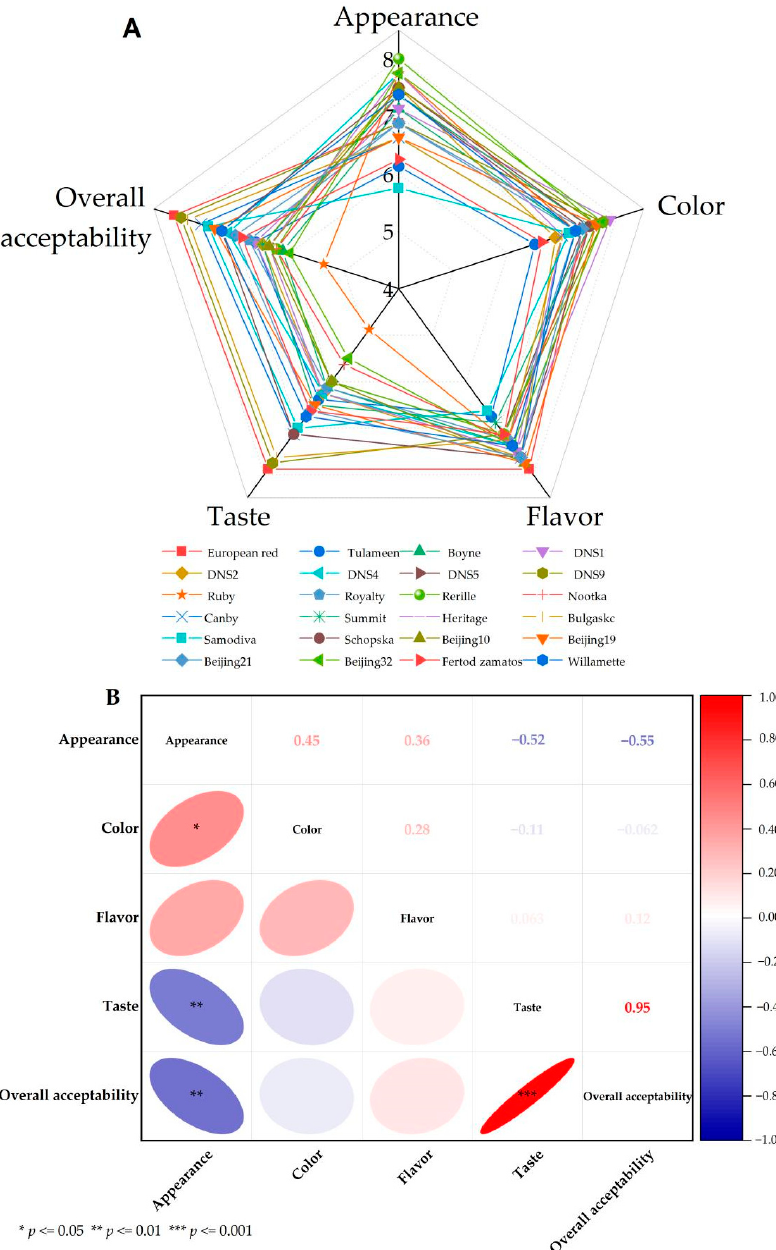
Figure 2. Radar plot showing sensory characteristics evaluation of 24 red raspberry varieties ( A ) and correlation analysis of five sensory characteristics ( B ). The correlation of five sensory characteristics (appearance, color, flavor, taste and overall acceptability) are shown in Figure 2B. It was observed that the taste was well cor- related to the overall acceptability ( r = 0.95, p ≤ 0.001). The appearance had significantly negative correlation with the taste and overall acceptability, with the correlation coeffi- cients of − 0.52 and − 0.55 ( p ≤ 0.01), respectively. These findings indicated that consumers tend to have a higher overall acceptability for fruits that taste better, and their vision may be affected by the attractiveness of fruit, while ignoring the smell of fruit. Considering these factors, future sensory evaluation should strengthen the potential sensory bias caused by flavor preference. 3.5. Ascorbic Acid Contents Ascorbic acid contents are one of the most important compositional parameters de- termining the nutritional and health related properties of plant foods [51]. The results of the present study (Figure 3) revealed differences in the ascorbic acid concentrations be- tween the studied varieties. According to our data, the average ascorbic acid contents of the red raspberry was 0.12 g/100 g DW. The ascorbic acid contents ranged from 0.03 to 0.24 g/100 g DW with ‘Schopska’ holding the highest content, yet ‘Ruby’ having the lowest content. Ascorbic acid has an important physiological role in numerous metabolic func- tions including tissue growth and maintenance, amelioration of oxidative stress, and im- mune regulation [52,53]. Van de Velde et al. revealed that ascorbic acid in red raspberry was associated with antioxidant effects, and the higher the concentration of ascorbic acid, the more powerful the ability to provide electrons or hydrogen atoms. A strong capacity of ascorbic acid to donate electrons or hydrogen atoms and then act as antioxidants to reduce the oxidative damage caused by reactive oxygen species (ROS) was also shown [54].